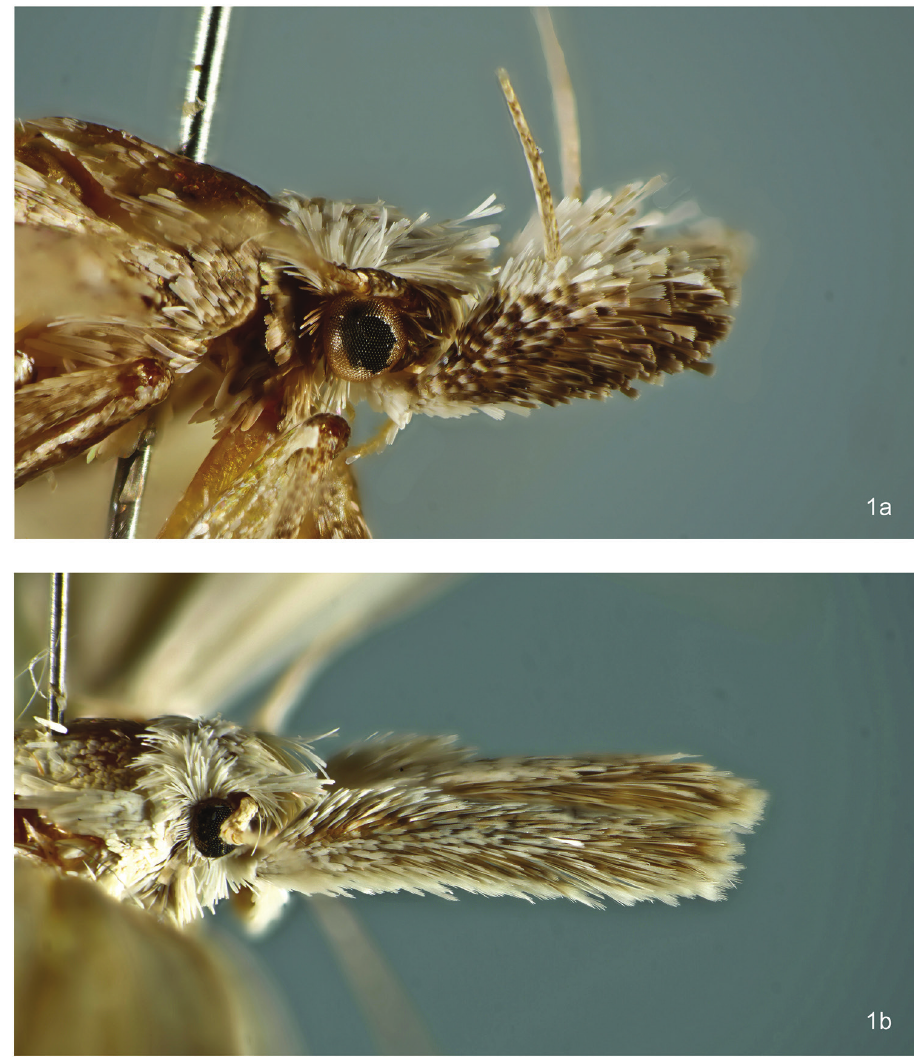
Figure 1. Labial palpus of Megacraspedus . a M. squalida Meyrick, 1926 b M. longipalpella Junnilainen, 2010. or otherwise modified; gnathos prominent, composed of rhombic base and strongly sclerotised, straight to strongly bent or curved large gnathos hook, articulated at lateral teguminal sclerites, length of gnathos hook usually equalling length of uncus; tegumen largely without specialised structures, lateral shoulders on the level of gnathos articula- tion, anteriomedial part with or without sclerotised rods, anterior margin moderately to deeply emarginated, anteromedially frequently with additional excavation; pedun- culi small, drop-shaped to large suboval; valva moderately slender to broadly digitate, straight to weakly curved, usually shorter than tip of uncus, exceptionally extending beyond uncus, large area of sensory setae on inner side, with or without